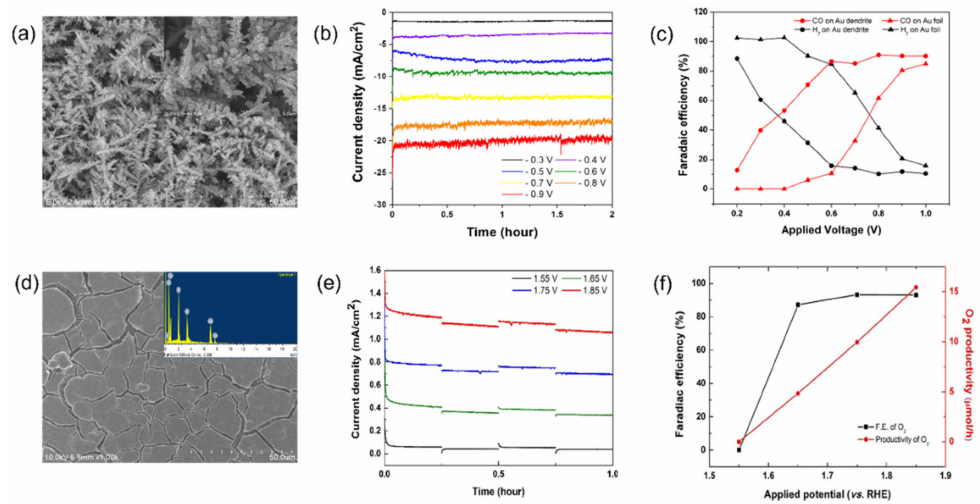
Figure 1. Electrochemical performances of cathode and anode: ( a ) SEM image of Au dendrite electrode. ( b ) Chronoamperometry test of CO 2 reduction by using Au dendrite electrode in the range from − 0.3 V to − 0.9 V (vs. RHE) in saturated 0.5 M KHCO 3 electrolyte. ( c ) Faradaic efficiency of Au dendrite and Au foil. ( d ) SEM image and EDS result of Co-Pi electrode. ( e )